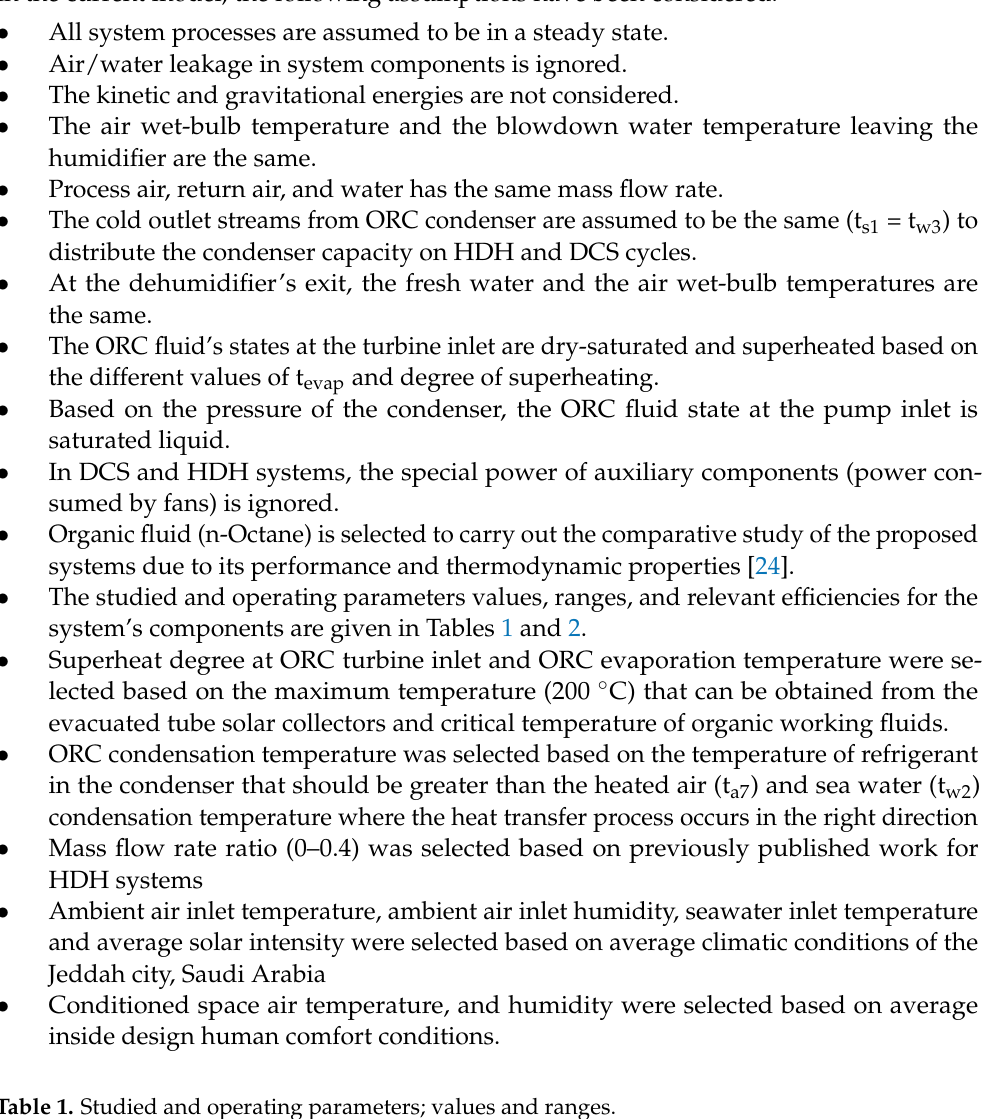
Table 1. Studied and operating parameters; values and ranges.